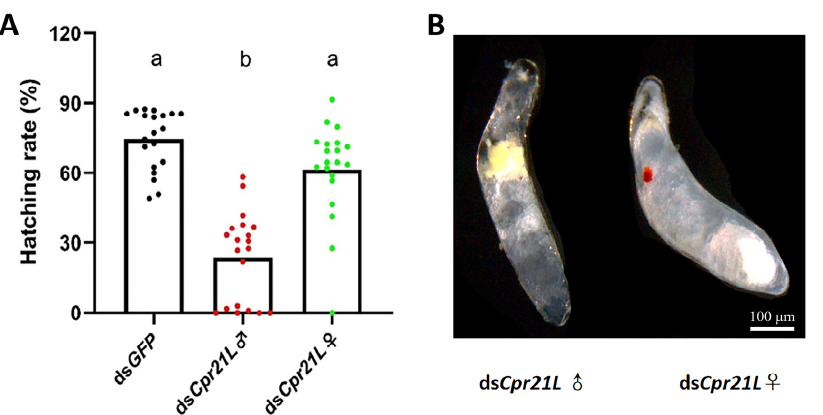
Figure 7. The effects of RNAi on the average number of eggs laid by one female BPH. Newly emerged females and males (1–12 h) were separately injected with ds GFP or ds Cpr21L and then mated 24 h later. ds GFP (control): ds GFP ♀ × ds GFP ♂ ; ds Cpr21L ♂ : ds Cpr21L ♂ × ds GFP ♀ ; ds Cpr21L ♀ : ds Cpr21L ♀ × ds GFP ♂ . Bars are the mean ± SEM from 20 females. The data were analyzed using one ‐ way ANOVA, followed by Tukey’s multiple comparison test. Different letters ʺ a ʺ and ʺ b ʺ on the bars indicate significant differences ( p < 0.05), while the same letter were not significantly different (P < 0.05).